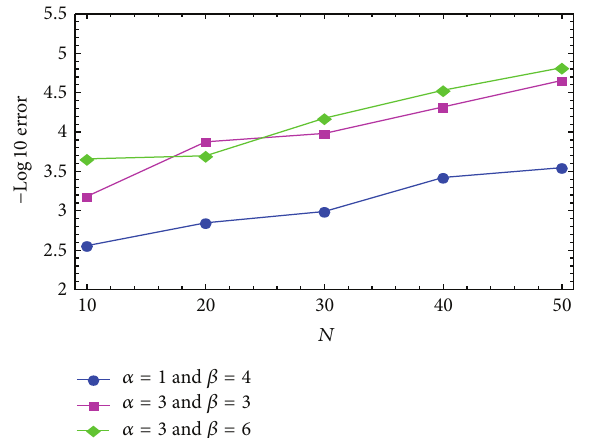
Figure 6: Maximum absolute error (case II) by using MGLT (Gauss) with various choices of 𝑁 .